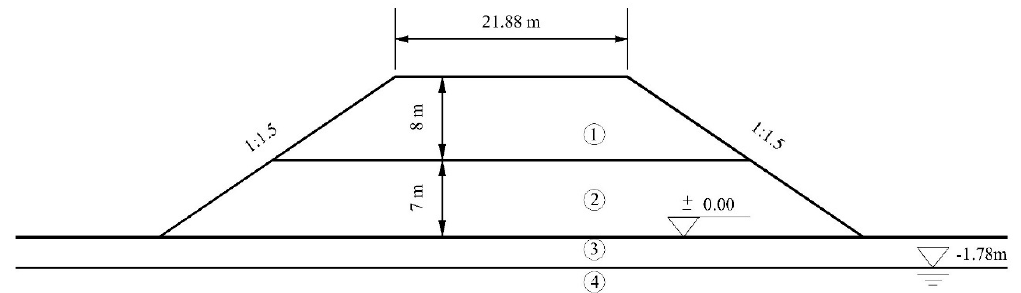
Table 2. Physic-mechanical properties of soil.